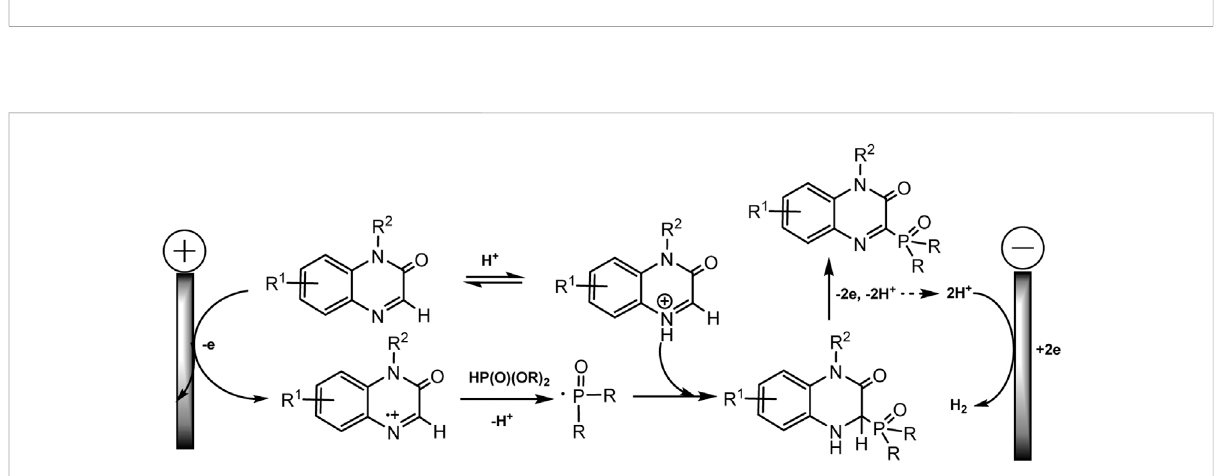
radical cation initiates the process. Simultaneously, protons reduction gives hydrogen evolution at the cathode (Zhu et al.,